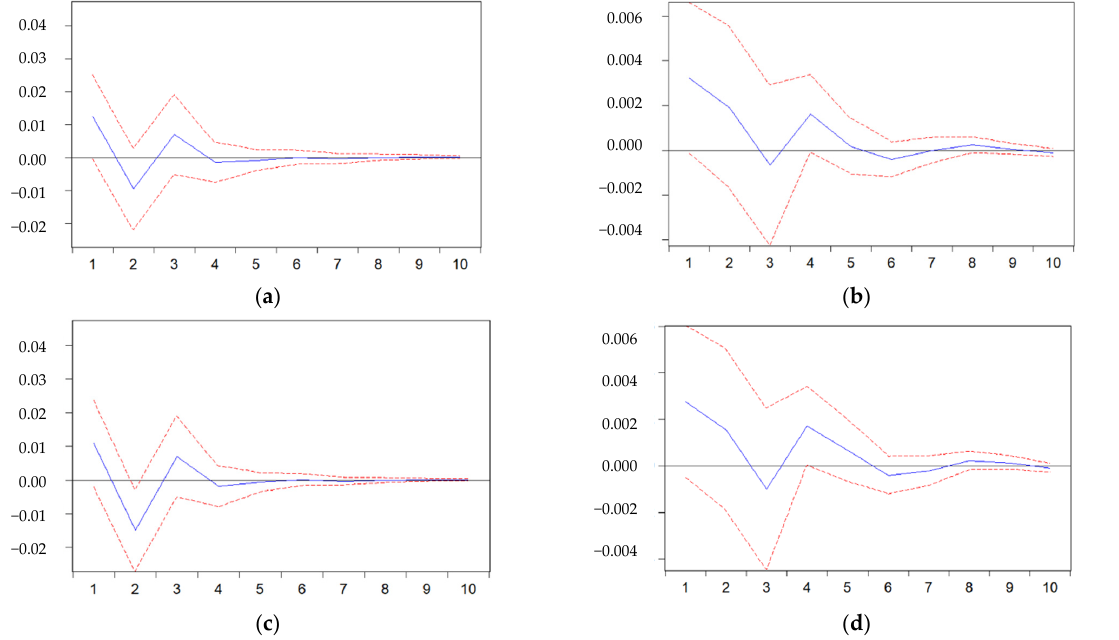
Figure 6. Generalized impulse response functions (pre-vaccine period for oil-importing countries). ( a ) Response of oil to the DAX index. It is shown that when the DAX index price is shocked by one standard deviation shock, the oil price positively responds 1 day after the shock. ( b ) Response of the DAX index to oil. It is shown that when oil price is shocked by one standard deviation shock, the DAX index price positively responds 1 and 4 days after the shocks. ( c ) Response of oil to the CAC40 index. It is shown that when the CAC 40 index price is shocked by one standard deviation shock, oil price negatively responds 2 days after the shocks. ( d ) Response of the CAC 40 index to oil. It is shown that when the oil price is shocked by one standard deviation shock, the CAC 40 index price positively responds 4 days after the shock.